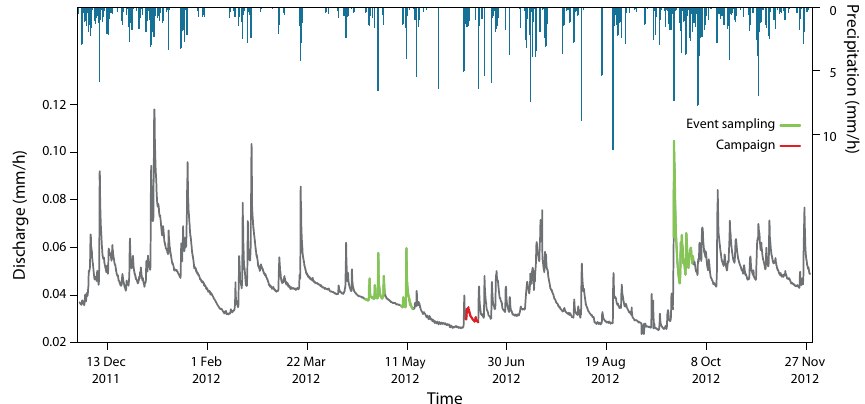
Figure 2. Precipitation and discharge during 2011–2012. Upper part: hourly precipitation measured 6km northwest of station 4. Lower part: the measured discharge at the catchment outlet (station 4). Table 1. Catchment characteristics and land use for each sub-catchment, with mean annual discharge, catchment size, specific discharge, distance from the source ∗ and land use.